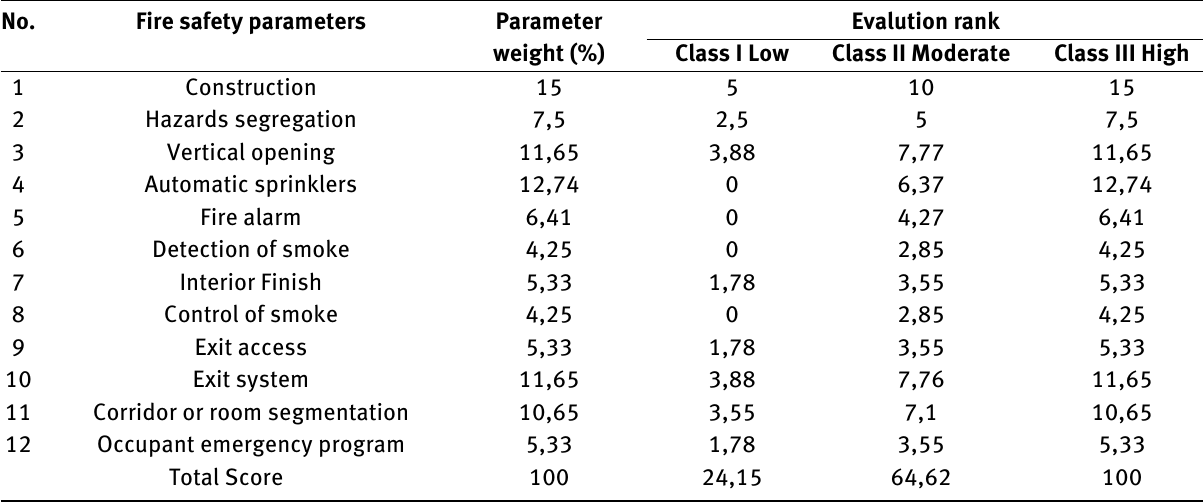
Table 3: Parameter weight analysis